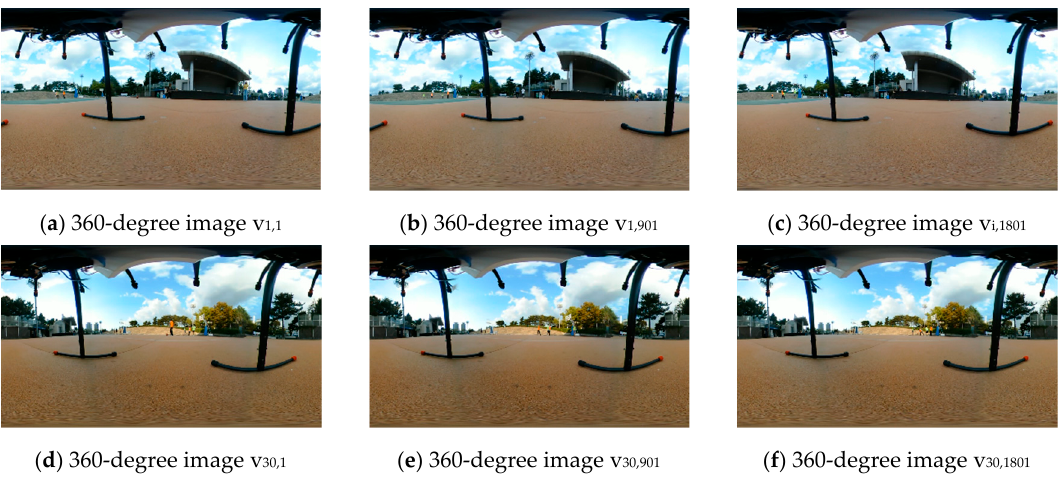
Figure 7. 360-degree video of four people playing basketball.